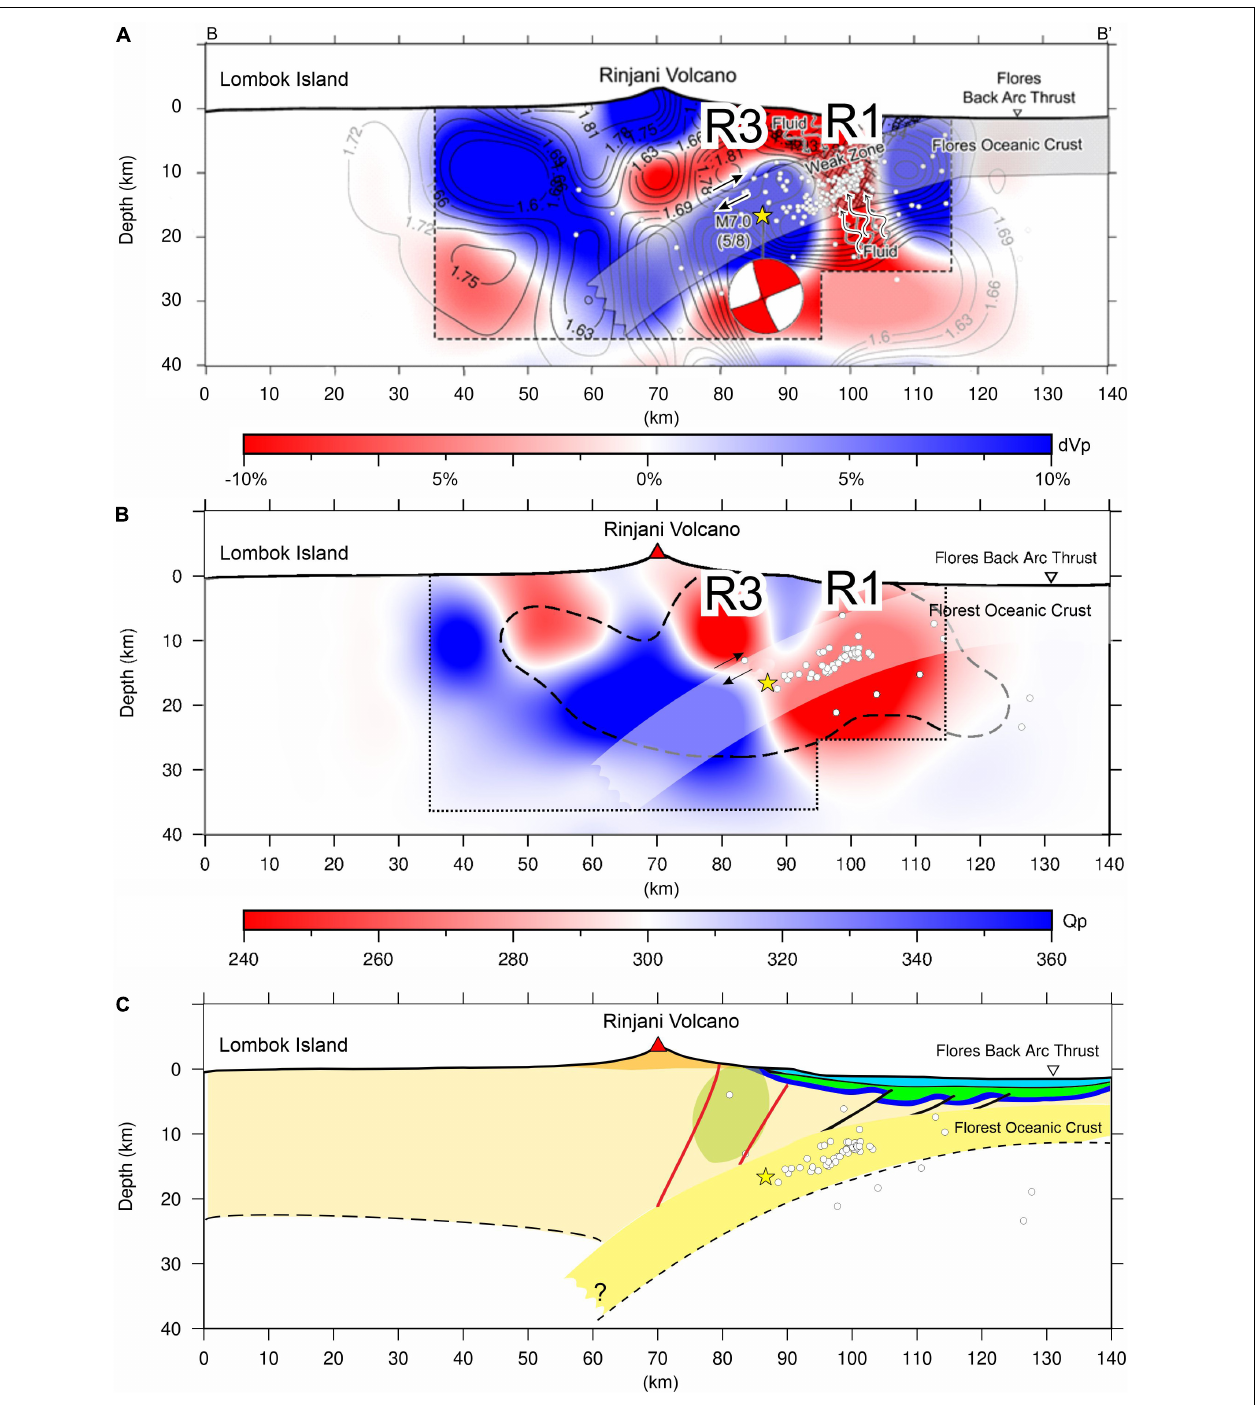
FIGURE 9 | Tectonic model of the Lombok based on seismicity, velocity, and attenuation tomography; (A) 2D interpretation of the crust beneath around Lombok based on the V p model along section BB’ (Afif et al., 2020); (B) 2D interpretation for the crust beneath around Lombok based on the Q p model along section BB (cid:48) ; (C) schematic diagram around Lombok Island. An inverted triangle marks the surface fault location based on Irsyam et al. (2017). The yellow star denotes the M 7.0 (August 5, 2018) which has a thrusting fault mechanism (Global CMT Catalogue). The white dots indicate the locations of hypocenters with a radius of 3 km from the centerline. The red lines indicate the faults from Supendi et al. (2020) and the black lines indicate the faults from Yang et al. (2020). The green area near the red lines (faults) indicates the high-temperature fluid content. The dark blue sediment layer represents the UpperMiocene limestone, the green sediment layer represents the Pliocene to present young sediment, and the light blue layer represents the ocean. Note that the difference in the number of hypocenters is due to the difference in the number of events before the spectral fitting procedure (A) and after spectral fitting procedure (B,C) .